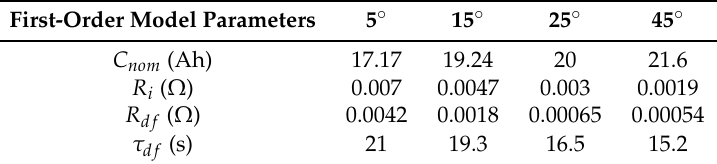
Table 2. The extracted parameters of the battery model of the charge at different temperatures.